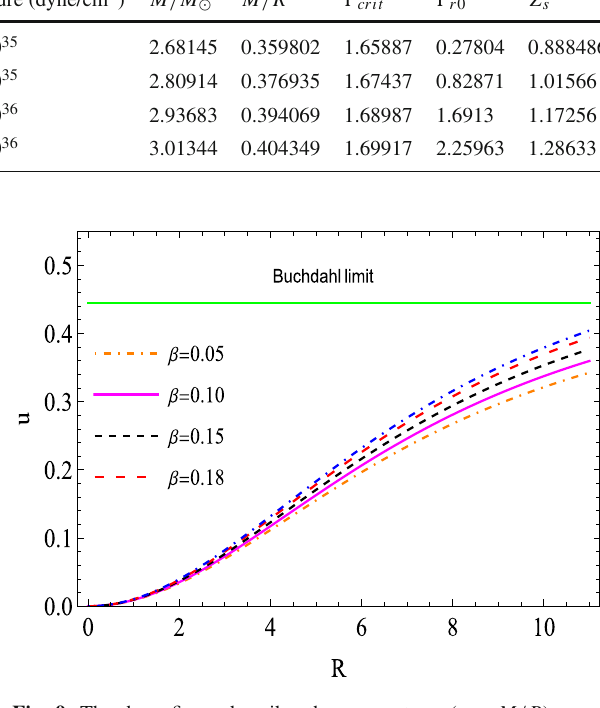
for different β Fig. 9 The above figure describes the compactness ( u = M / R ) versus d ρ eff 0 radius ( R